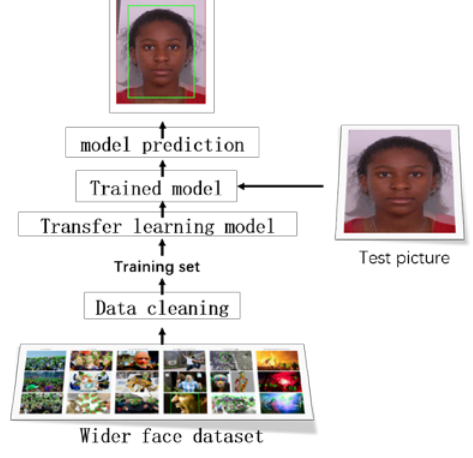
Fig. 1. Flow chart of face